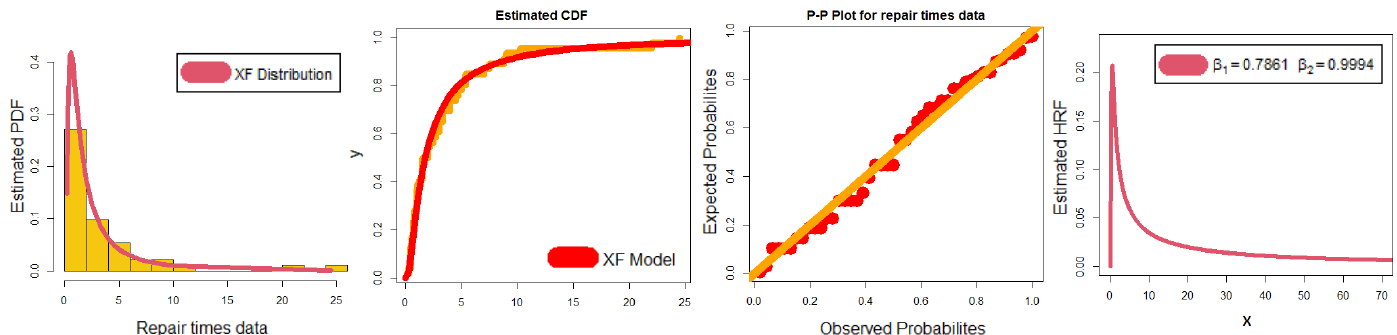
Figure 4: The estimated PDF, estimated CDF, PP and estimated HRF